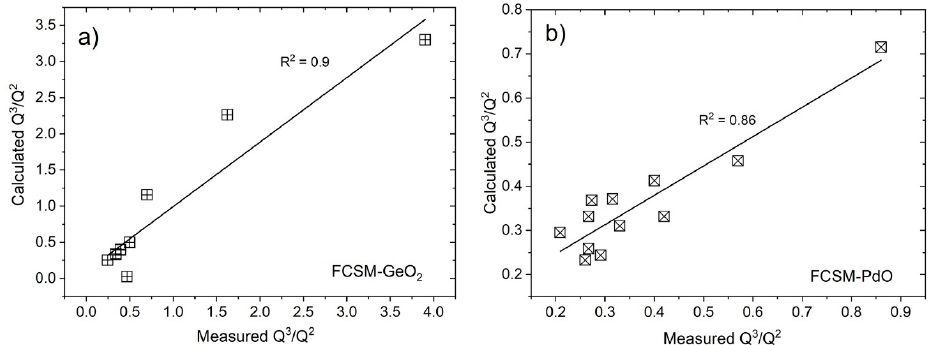
Figure 15. Comparison of calculated and measured values of the Q 3 /Q 2 for ( a ) FCSM-Cu 2 O-GeO 2 and ( b ) FCSM-Cu 2 O-PdO slags. ( b ) FCSM-Cu 2 O-PdO